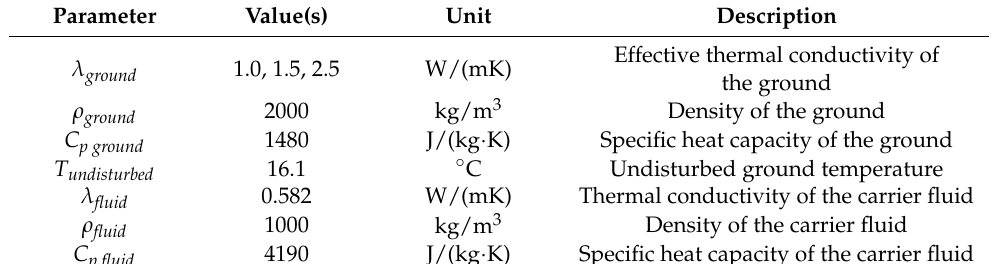
Table 2. Material properties.